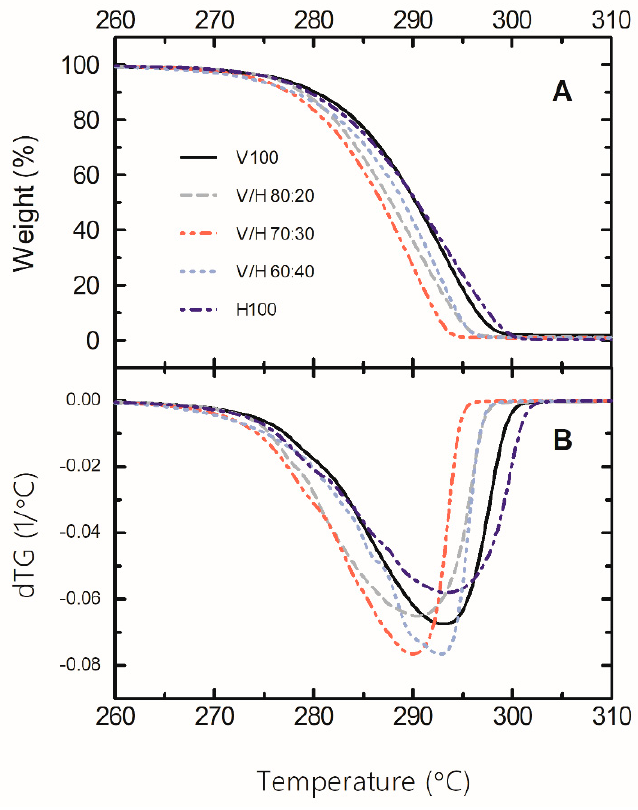
Figure 9. Thermogravimetrical analysis (TGA) ( A ) and derivative thermogravimetric (DTG) ( B ) curves of poly(3-hydroxybutyrate- co -3-valerate) (PHBV), poly(3-hydroxybutyrate- co -3-hydroxyhexanoate) (PHBH), and their blends.